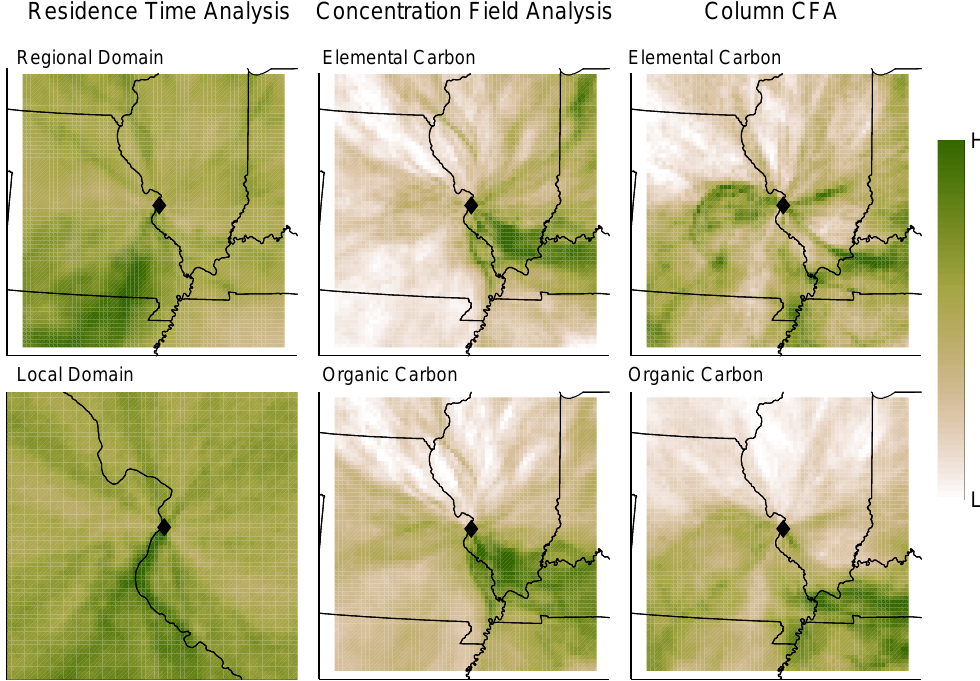
Figure 7. Left: residence time analysis of FLEXPART-WRF back trajectories using hourly releases during 2002 showing the origin of air masses arriving at the supersite (diamond). Center: concentration field analysis of EC and OC showing air mass transport associated with peak concentrations. Right: column concentration field analysis of EC and OC showing air mass transport associated with higher column amounts of EC and